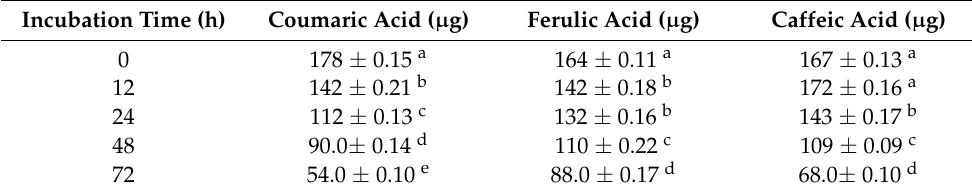
Table 2. Quantification of hydroxycinnamic acids in rumen fluids after different incubation periods by HPLC-DAD method.